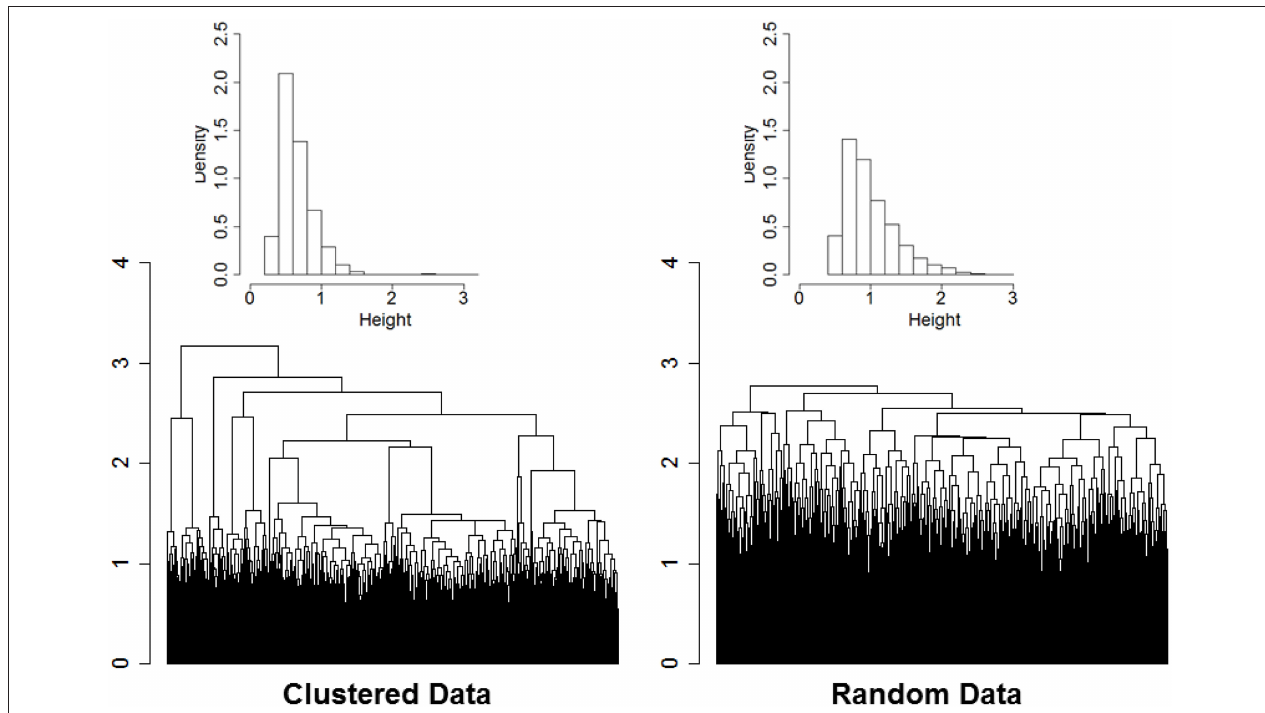
FIGURE 1 | Dendrogram of hierarchical clustering of 2000 profiles of 16 variables generated from 13 clusters, with cluster size ranging from 2 to 532 (left panel), and dendrogram generated from the same data after reshuffling of the rows (right panel). Data were generated from multivariate normal distributions and standardized by row. The histograms describe the distributions of the heights of the branch points.